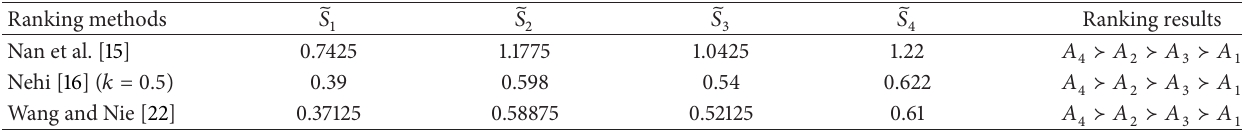
Table 2: Ranking of TrIFNS using different